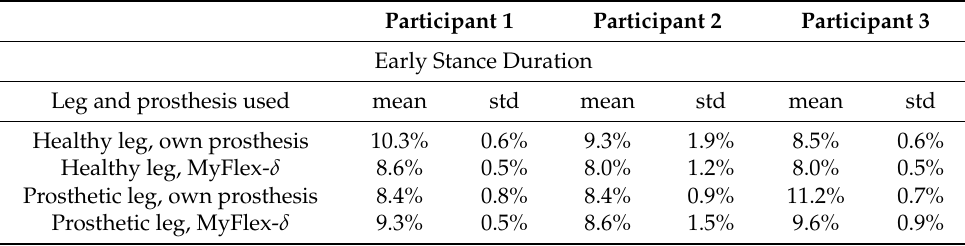
Table 9. Stance phase subphases durations. Mean values (mean) and standard deviations (std) are calculated from 50 gait